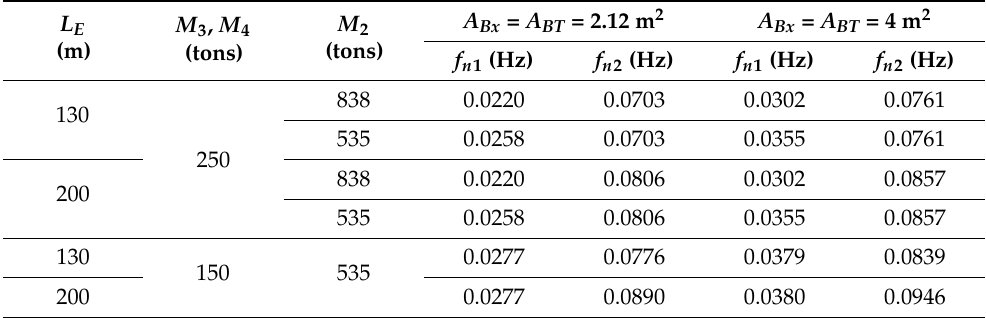
Table 2. The first two natural frequencies f n1 and f n2 as a function of the masses M 3 , M 4 and M 2 , the distance L E and the areas A Bx ,A BT for M 1 = 300 tons.